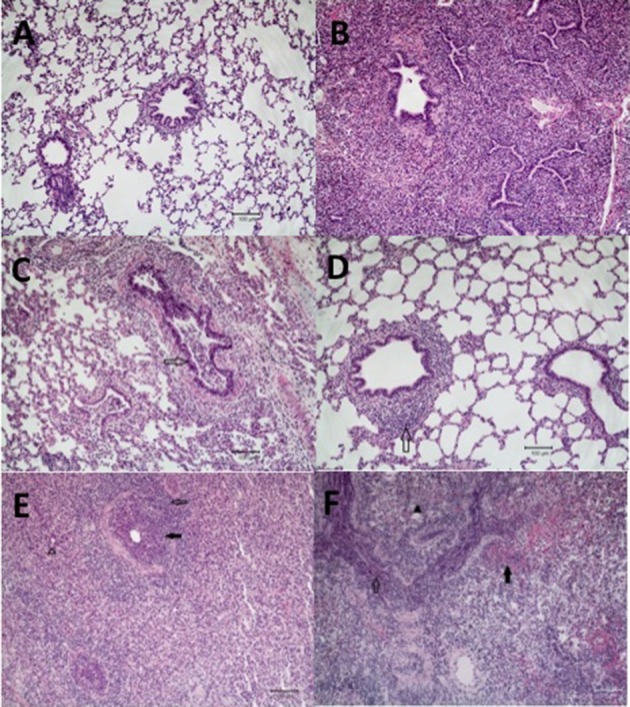
Microscopic lung lesions from representative pigs at necropsy. Groups of pigs were inoculated with B. bronchiseptica (Bb) on day−7, LAIV on days 0 and 21, and subsequently challenged (Ch) with heterologous IAV on day 42 as described in materials and methods. A Non-vaccinated (NV) group and a NV/non-challenged (NV/NCh) control group were included as controls. At 5 days post-infection lung sections were collected at necropsy and processed as described in materials and methods. Photomicrographs showing (A) normal lung in a non-infected control pig (NV/NCh); (B) interstitial thickening due to fibroplasia with mononuclear alveolar infiltrates in a pig chronically infected with Bb-only (Bb/NV/NCh); (C) suppurative bronchiolitis with epithelial necrosis (open arrow), characterized by loss of cilia and nuclear pyknosis, from a pig infected with IAV-only (NV/Ch); (D) peribronchiolar lymphocyte infiltration and BALT hyperplasia (open arrow) in a vaccinated pig challenged with IAV (LAIV/Ch); (E) suppurative bronchiolitis with epithelial necrosis (closed arrow), submucosal lymphohistiocytic inflammation, peribronchiolar lymphocytic infiltration (open arrow), interstitial pneumonia, and alveoli filled with neutrophils (open arrow head) demonstrating lesions of IAV infection and acute Bordetellosis in a pig that was infected with Bb and subsequently challenged with IAV (Bb/NV/Ch); and (F) alveoli and bronchioles filled with neutrophils and mononuclear cells (open arrow), alveoli with areas of epithelial necrosis and hemorrhage (closed arrow), and interstitial pneumonia (closed arrow head) demonstrating lesions of acute Bordetellosis in a vaccinated pig that had been infected with Bb and subsequently challenged with IAV (Bb/LAIV/Ch). Macropscopic pneumonia score for pig in which representative sections were selected are indicated with a red data point in Figure 2.